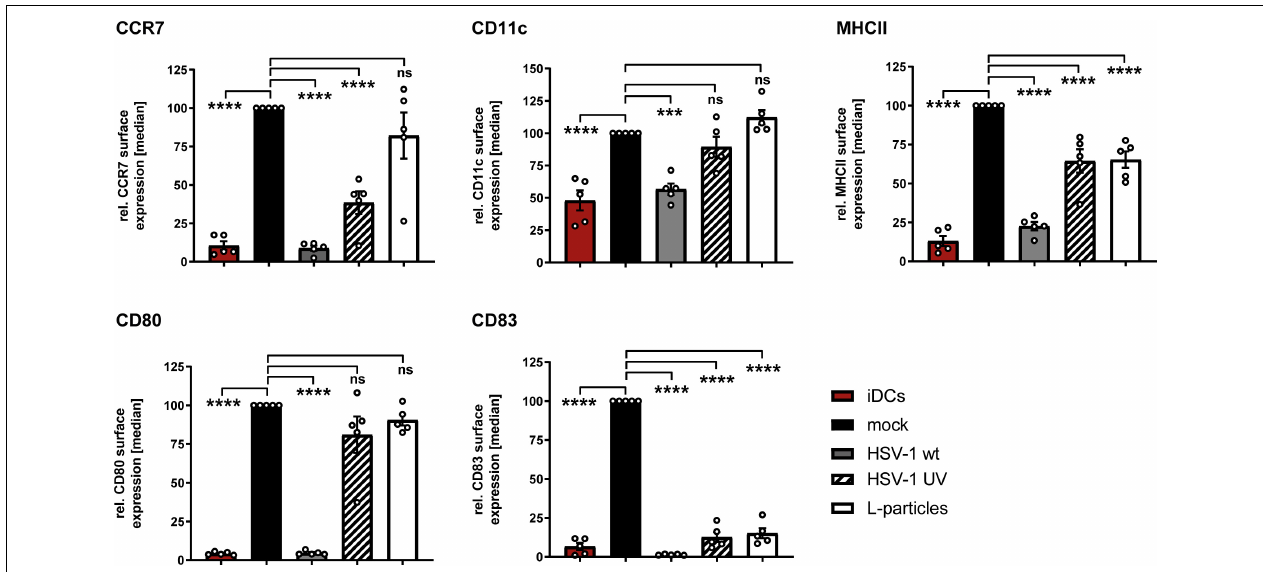
FIGURE 7 | L-particles selectively interfere with CD83 surface expression during DC maturation. Immature DCs (iDCs) were infected with HSV-1 (MOI of 2), treated with UV-inactivated HSV-1 (viral material corresponding to MOI of 20, 8 × 0.12 J/cm 2 ) or L-particles (viral material corresponding to high MOI, 3 × 0.12 J/cm 2 ) or left untreated. At 1hpi, infected cells were transferred into medium containing a defined maturation cocktail. An uninfected iDC sample served as an input control and was directly stained against CD11c, CD80, CD83, CCR7, and MHC class II (MHCII) for flow cytometric analyses. Cells were harvested 24 hpi, stained with specific antibodies mentioned before and used for flow cytometry. The experiment was performed five times with cells from different healthy donors. Error bars indicate SEM. Significant changes to mock were analyzed using a one-way ANOVA and Bonferroni multiple comparison post hoc tests and are indicated by asterisks (***indicates p ≤ 0.001 and **** p ≤ 0.0001) and values depicted as “ns” were not significant ( p < 0.05).